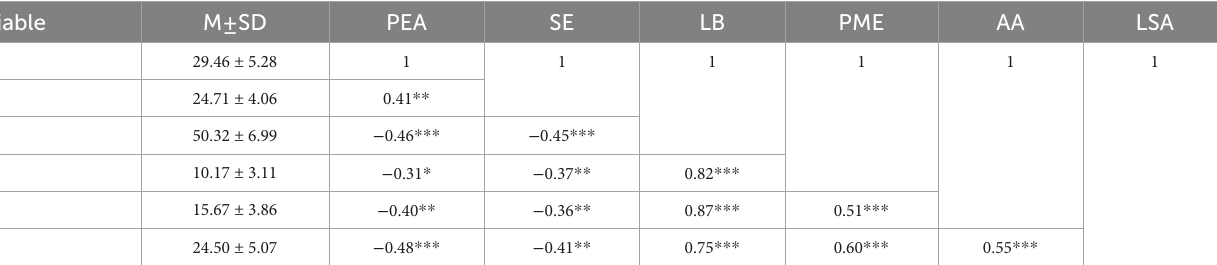
TABLE 3 Correlation between physical exercise amount, self-efficacy, and learning burnout.